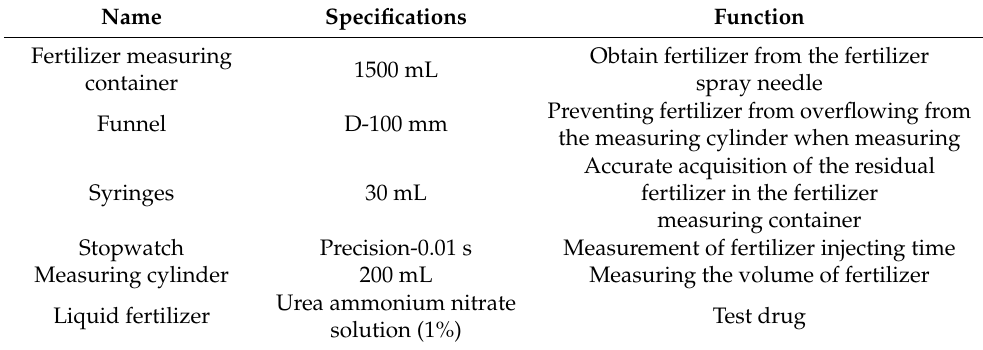
Table 1. The main equipment used for the